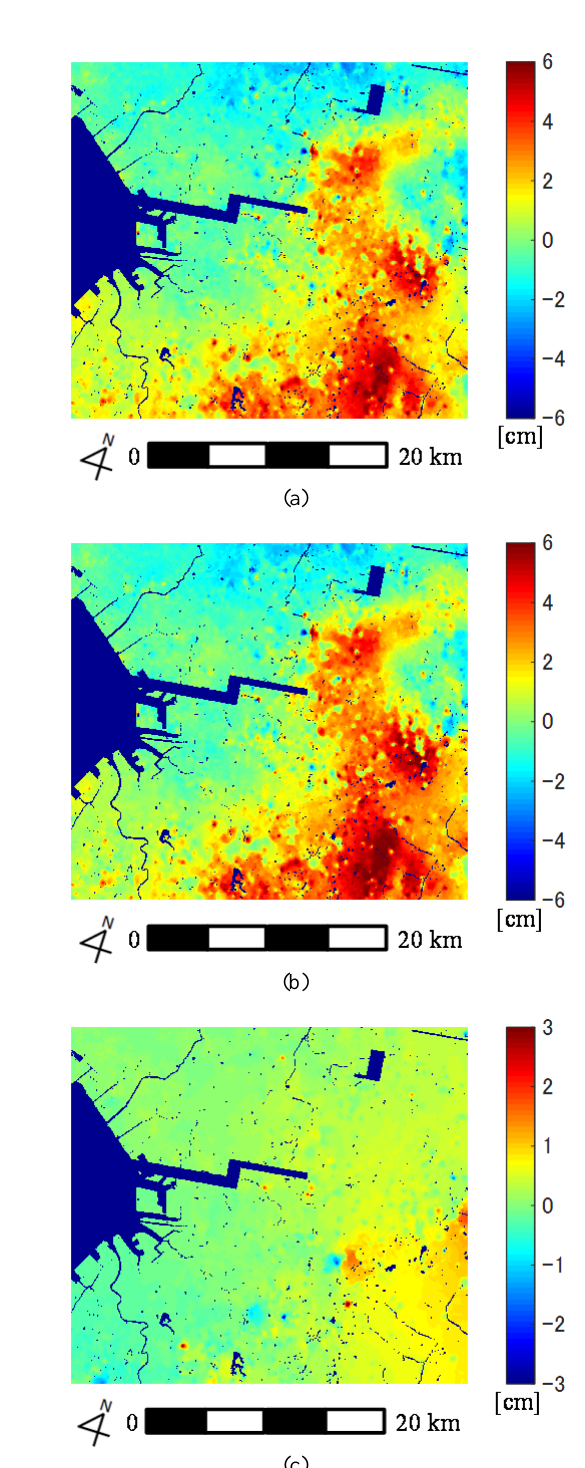
Figure 7. Contrasting results using the traditional PSInSAR technique and those using the proposed method: (a) deformation derived using traditional PSInSAR (Ferreti et al., 2000); (b) deformation derived using proposed method; (c) difference between (a) and (b). Positive and negative deformation values denote uplift and subsidence, respectively.